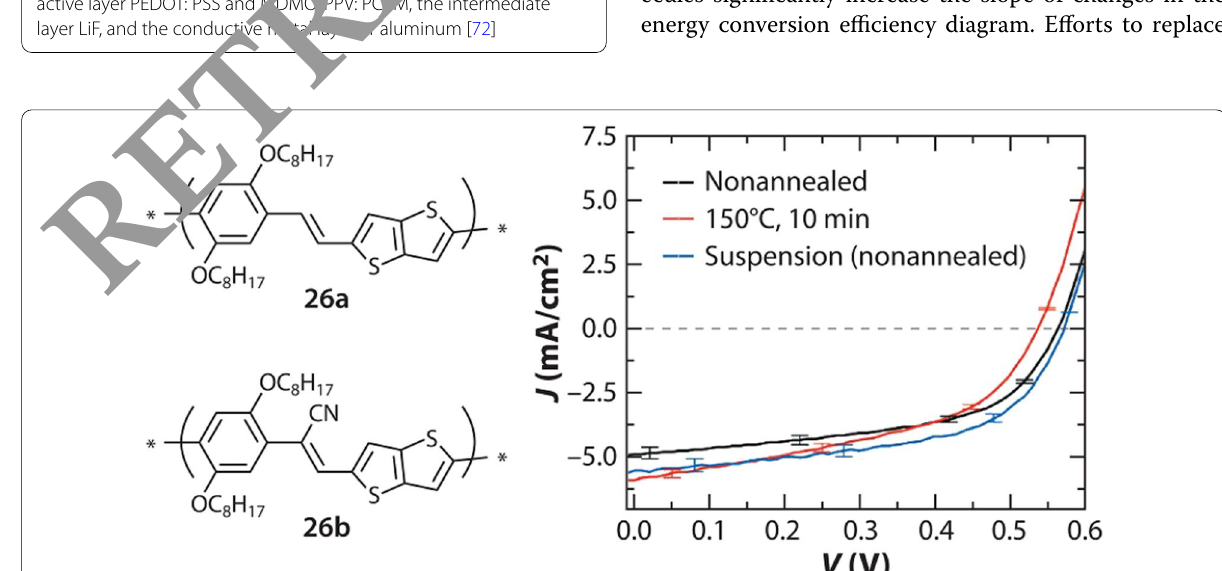
Fig. 11 a Schematic of the general structure of organic solar cells; b the TEM image of the said solar cell. This solar cell has several single layers: glass or SiO 2 , indium tin oxide or ITO, clear polymers and the active layer PEDOT: PSS and MDMO-PPV: PCBM, the intermediate layer LiF, and the conductive metal layer or aluminum [72]